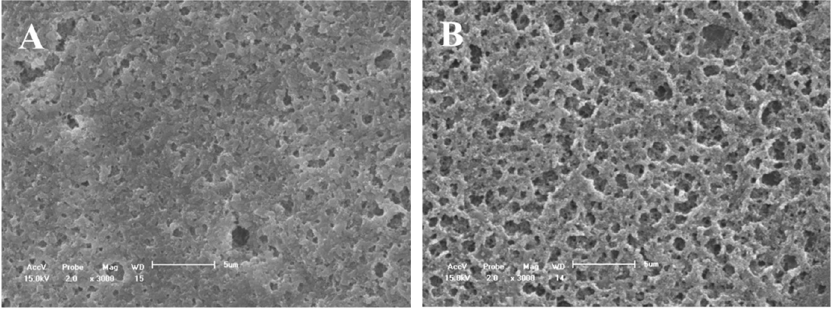
Figure 3. SEM micrographs of the dentine surface morphology at 3000× magnification. ( A ) Adhesive without nanofiber and ( B ) after 6% citric acid challenge. A more porosity surface was verified in ( B ).